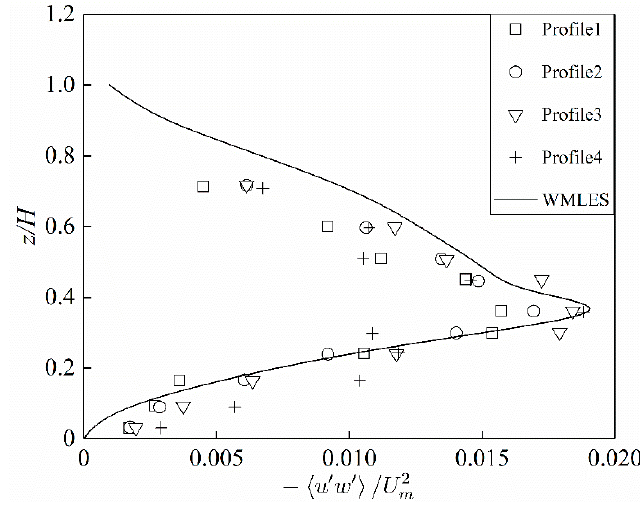
Figure 5. Comparison of dimensionless Reynolds stress.